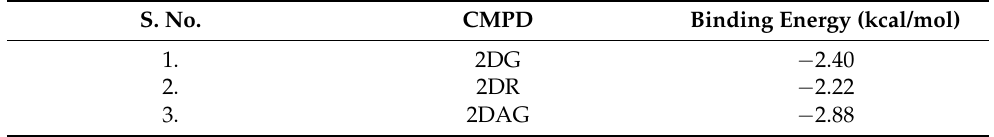
Table 2. Binding energy of the